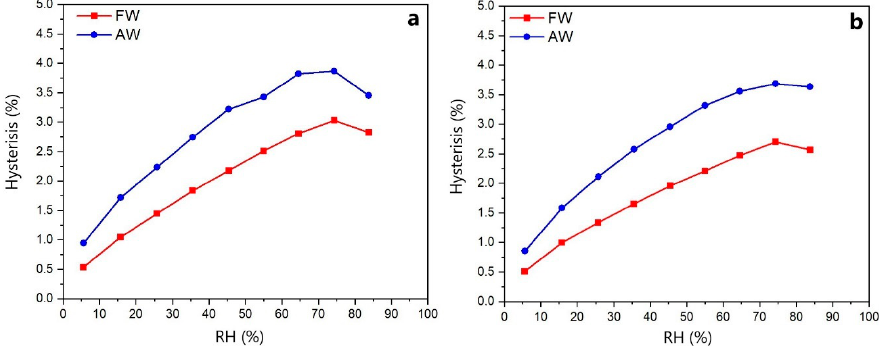
Figure 5. Sorption hysteresis of archaeological and fresh elm ( a ) and polar ( b ) at a given RH